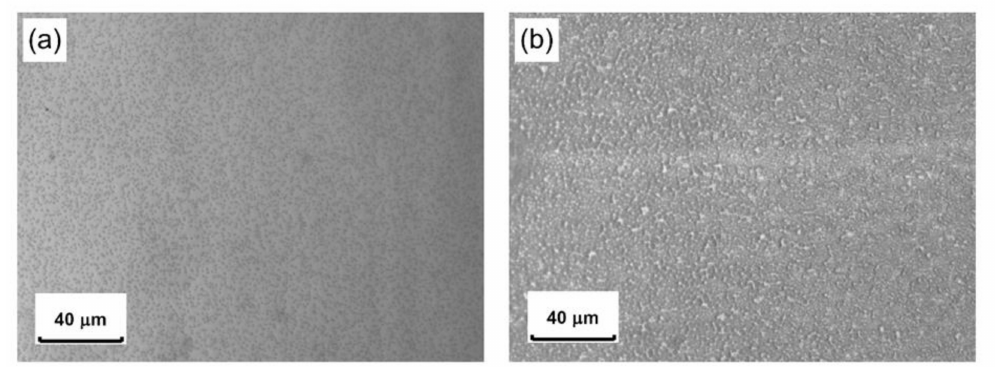
Figure 12. Optical microscope images of the thiol-ene surface at 750x magnification: ( a ) imprinted at room temperature under 30 MPa for 70 h, ( b ) hot embossed at 100 ◦ C under 30 MPa for 1 h.